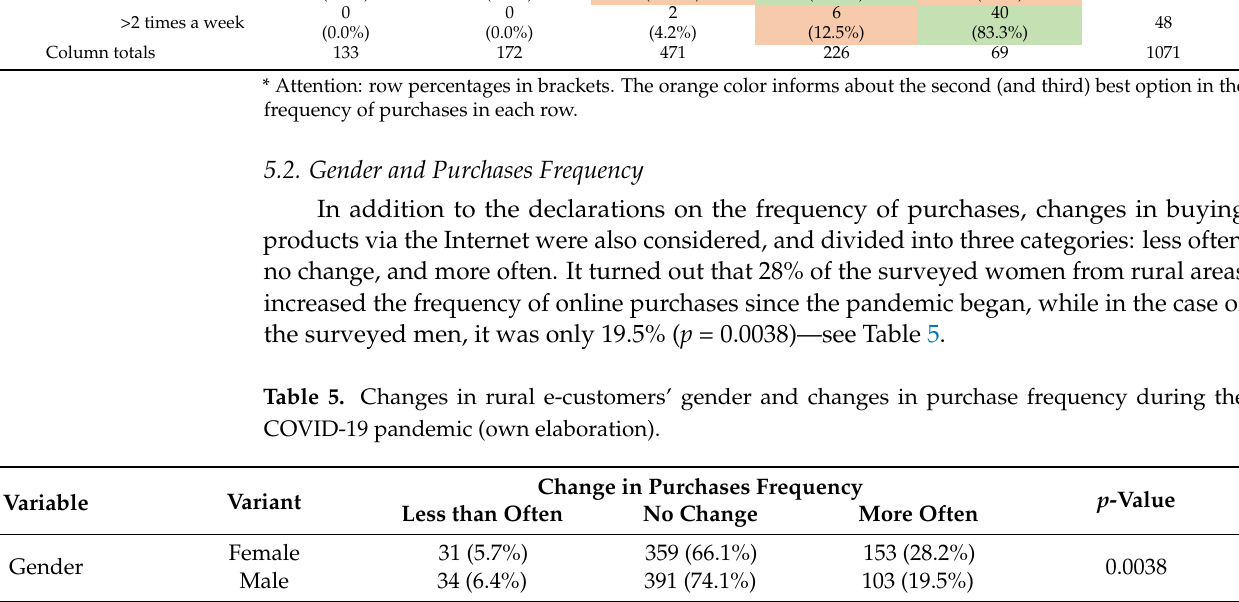
* Attention: row percentages in brackets. The orange color informs about the second (and third) best option in the frequency of purchases in each row.